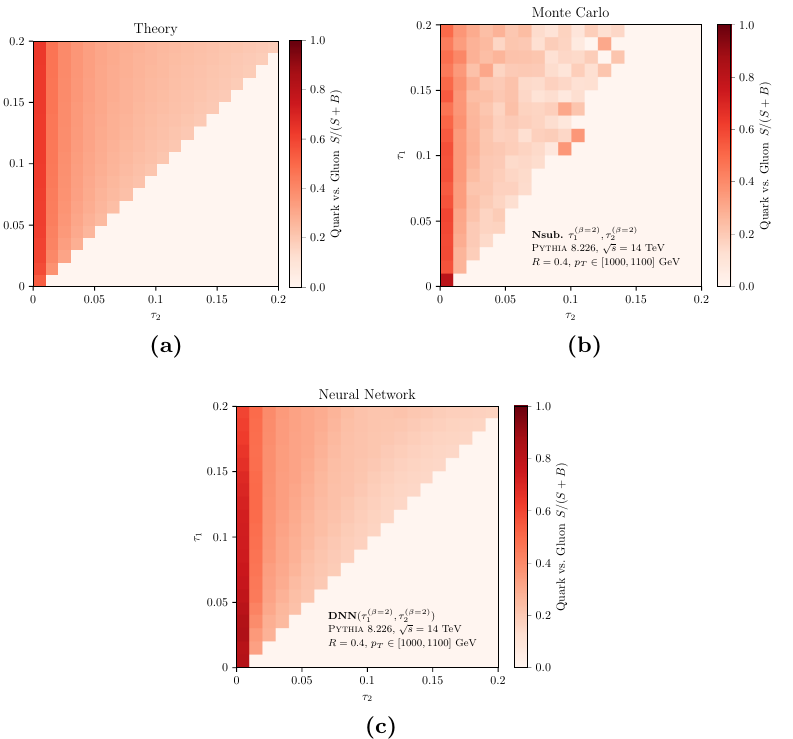
Figure 15. S= ( S + B ) for quarks ( S ) vs. gluons ( B ) in the ( (cid:28) determined by (a) the prediction of eqs. (6.17) and (6.18) using (cid:11) s = 0 : 118, (b) Monte Carlo histogram counts, and (c) the output of a neural network trained to classify quarks and gluons. The and correctly predicts its saturation around C 2